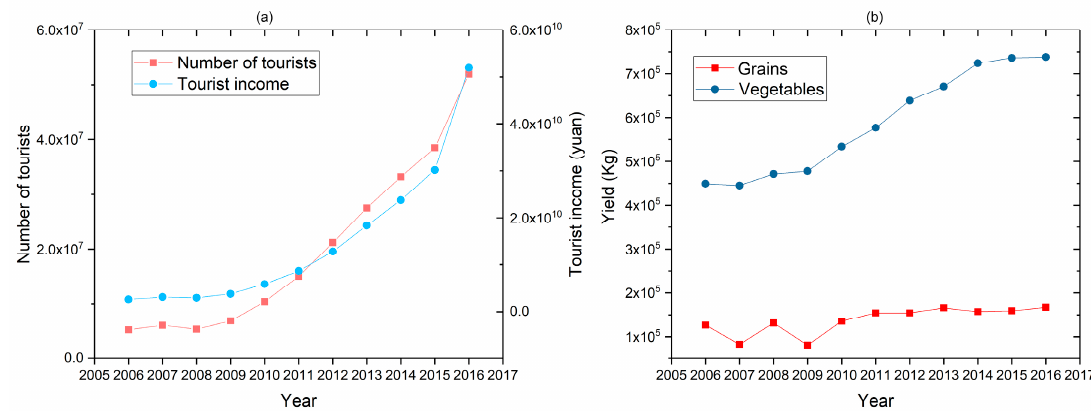
Figure 9. Economic and social development statistical bulletin data from 2006 to 2016. ( a ) Number of tourists and tourist income; ( b ) yields of grains and vegetables.